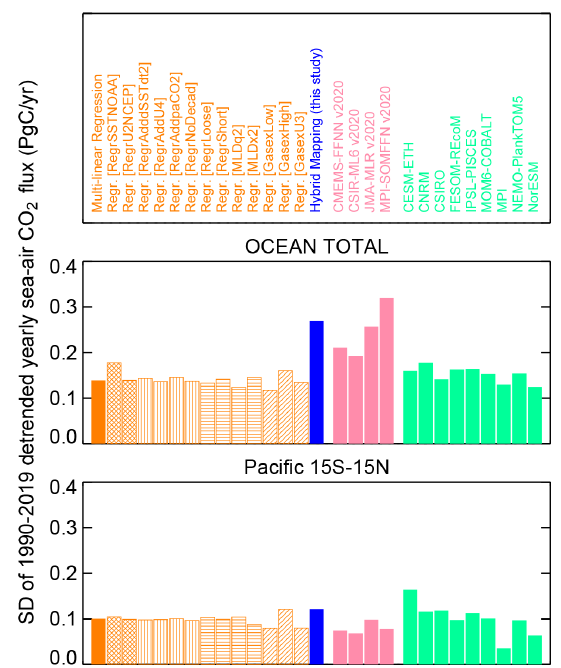
Figure 8. Amplitudes of variability in the sea–air CO 2 flux on year- to-year timescales around its secular trend, from the multi-linear re- gression (orange group of bars; solid: base case; hashed: uncertainty cases) and the hybrid mapping (blue), compared to other p CO 2 mapping methods (salmon; CMEMS v2020, Denvil-Sommer et al., 2019; CSIR-ML6 v2020, Gregor et al., 2019; JMA-MLR v2020, Iida et al., 2020; and MPI-SOMFFN v2020, Landschützer et al., 2013) as well as the ocean biogeochemical process models collated in Friedlingstein et al. (2020) (mint green). The amplitudes are rep- resented by temporal standard deviations of detrended yearly fluxes over the 1990–2019 period. The top panel gives the global flux, the bottom panel the tropical